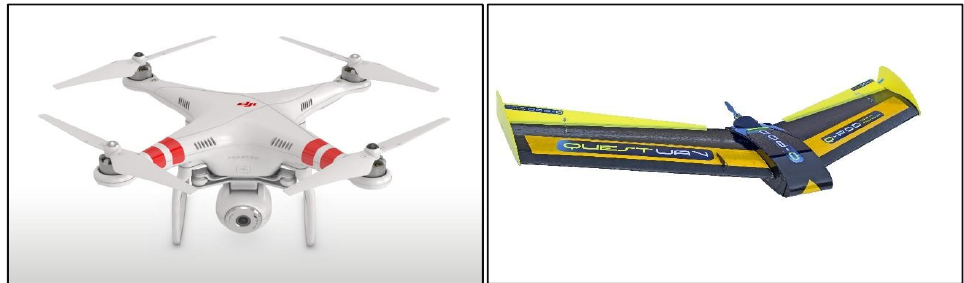
Figure 1. DJI Phantom 2 quadcopter UAV (left) and a Quest Q-Pod fixed-wing UAV (right). UAVs of this size with <20 kg mass and <4 m wingspan are classified as ‘small’ UAVs [24]. (Photographs adapted from [25,26]).